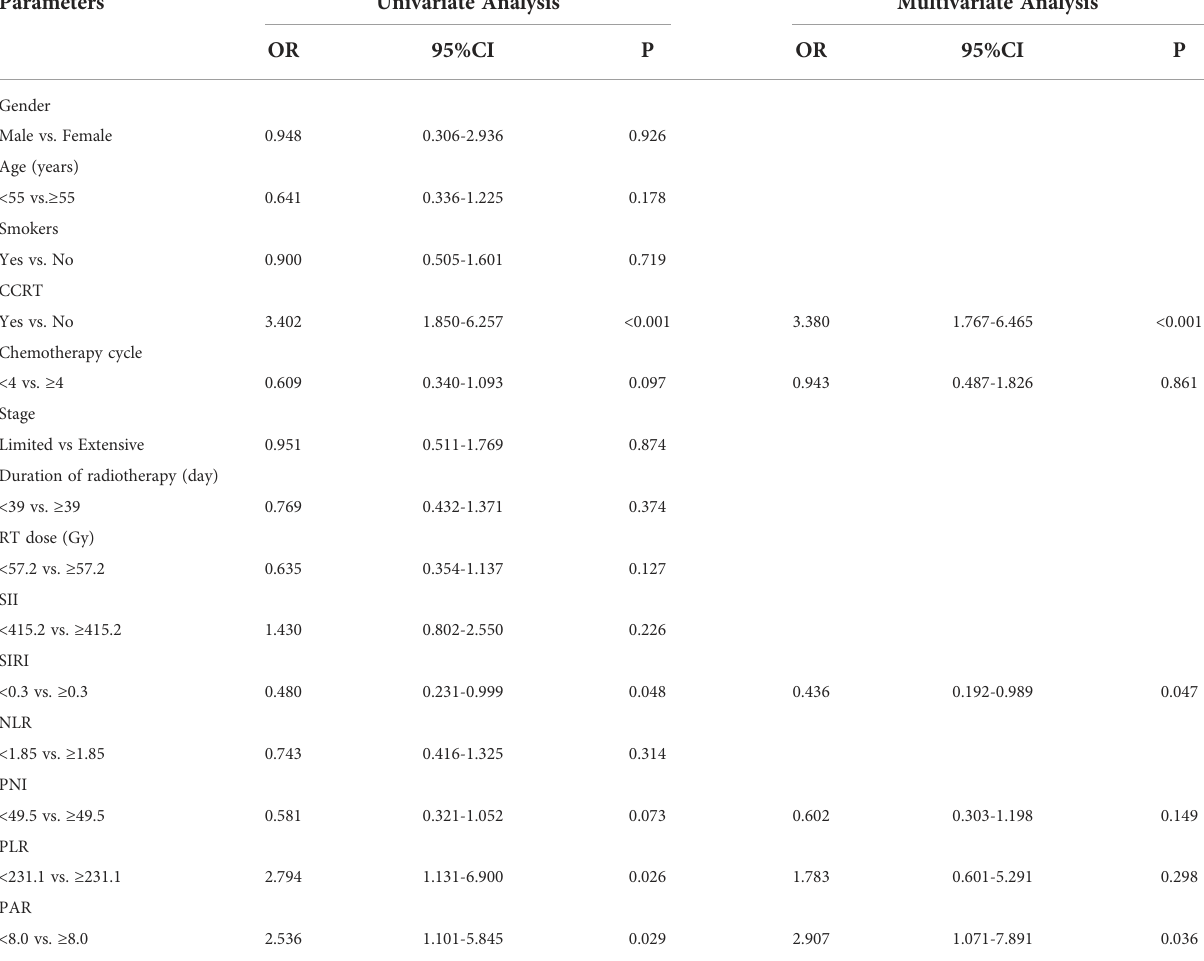
TABLE 2 Univariate and multivariate logistic regression analysis of the clinical, dosimetric factors and in fl ammation indexes in predicting grade ≥ 2 RE. Parameters Univariate Analysis Multivariate Analysis OR 95%CI P OR 95%CI